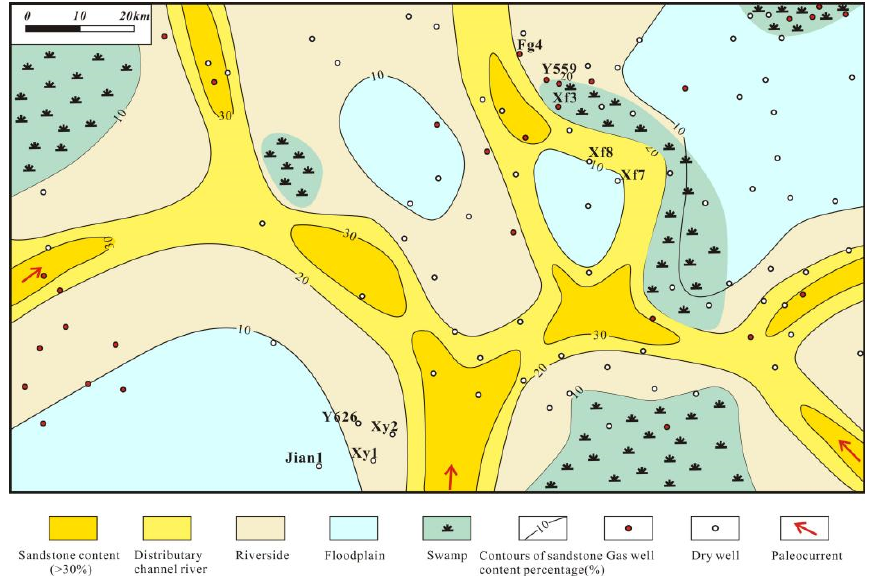
Figure 14. Sedimentary facies diagram of the Shanxi Fm. in the southeastern Ordos Basin.